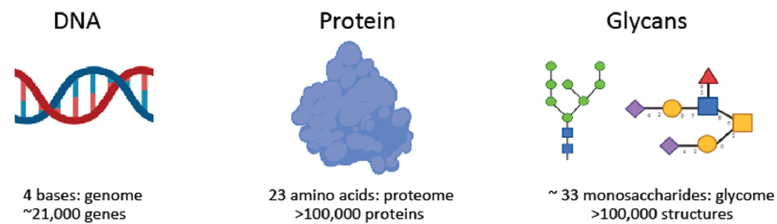
Figure 1. Glycans, the understudied major building blocks of life. The glycoproteome combines three highly adaptable interdependent biological alphabets. Created with BioRender.